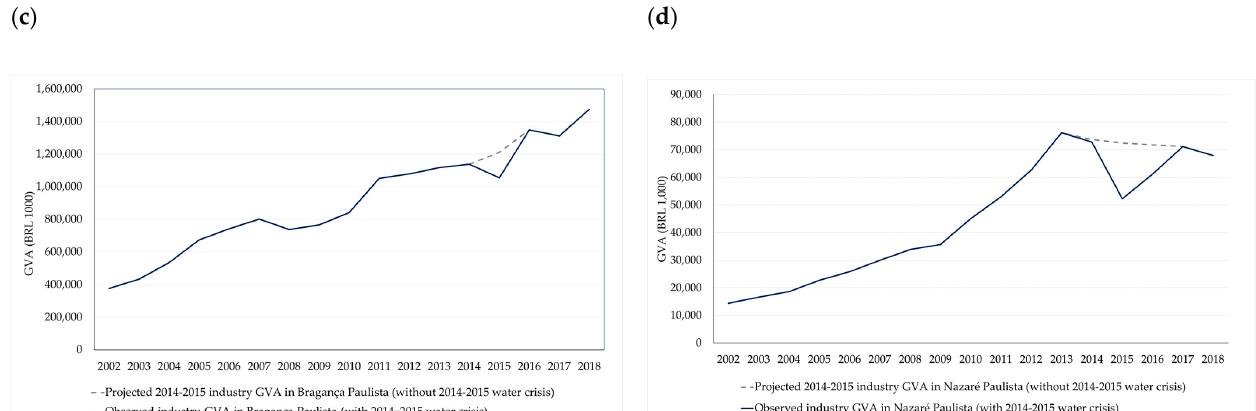
Table 5. Water sector NVA loss by municipalities served by CWSS (BRL 1000). Municipalities